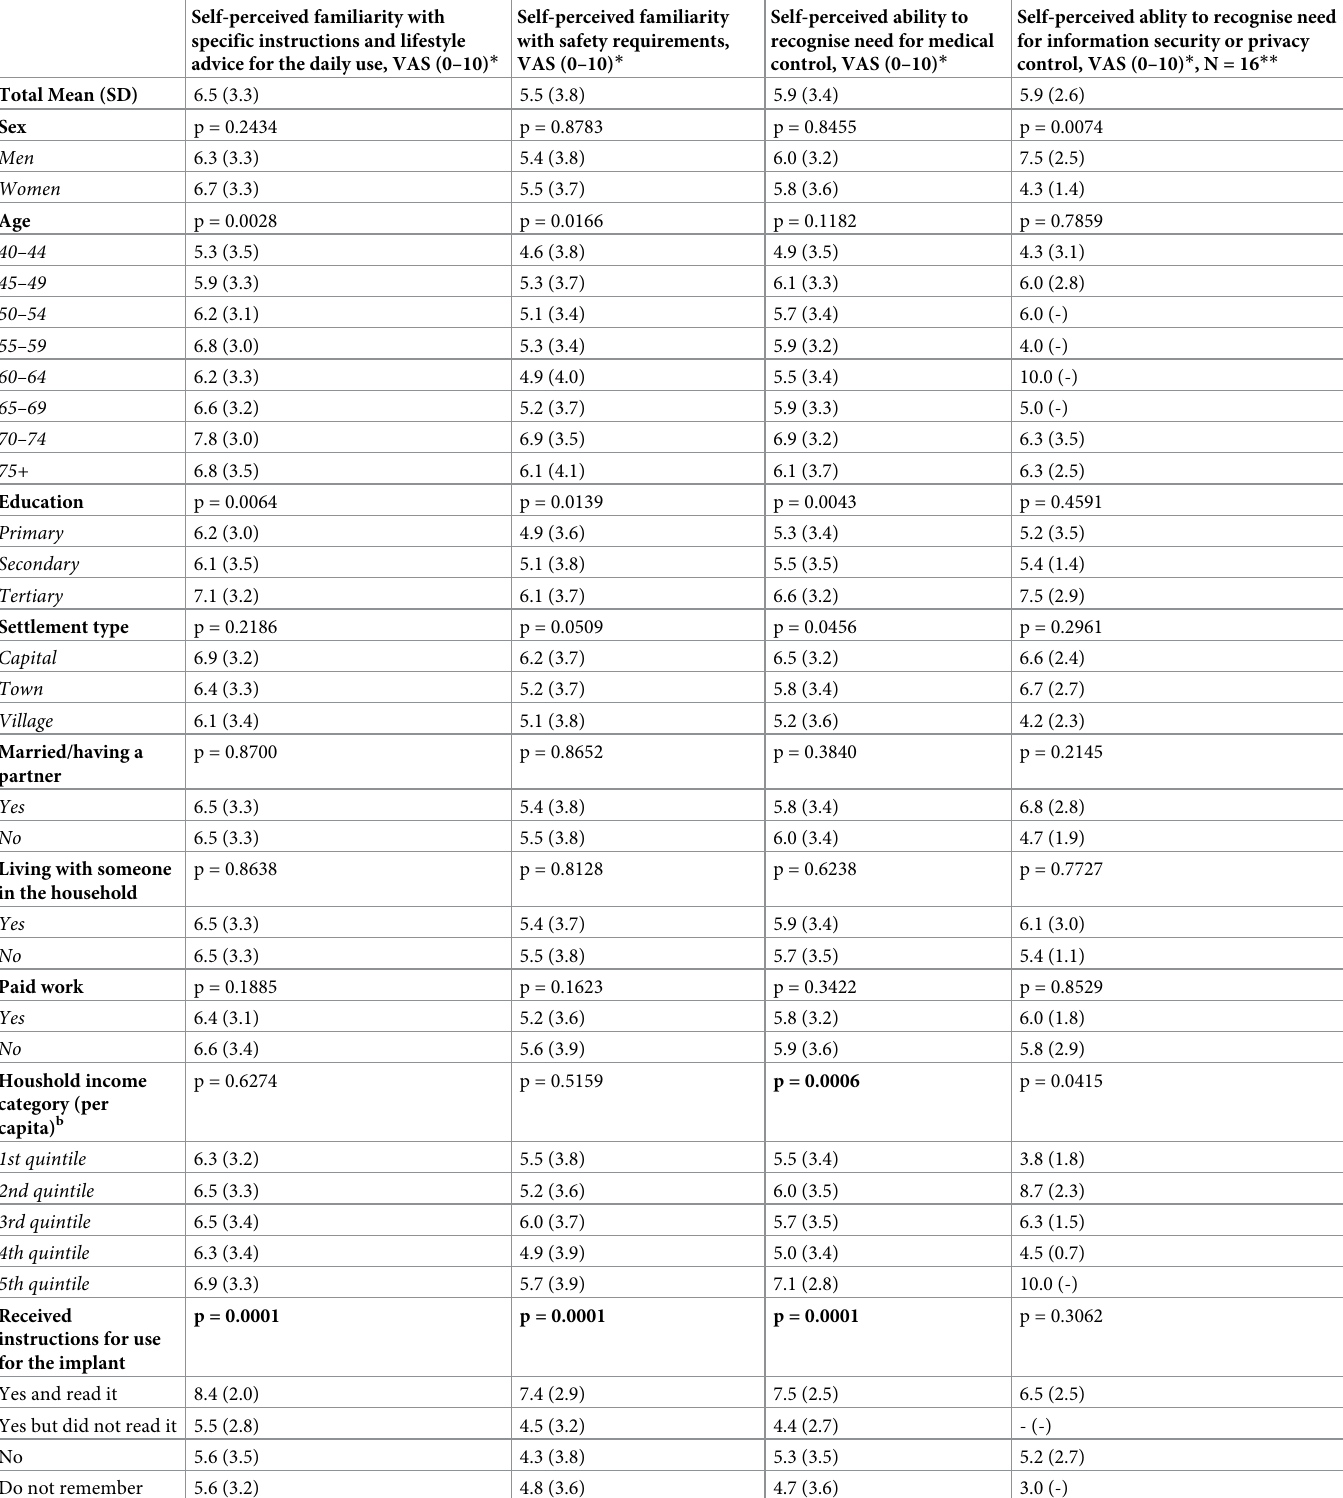
Table 3. Patients’ knowledge regarding living with implantable medical device (N =